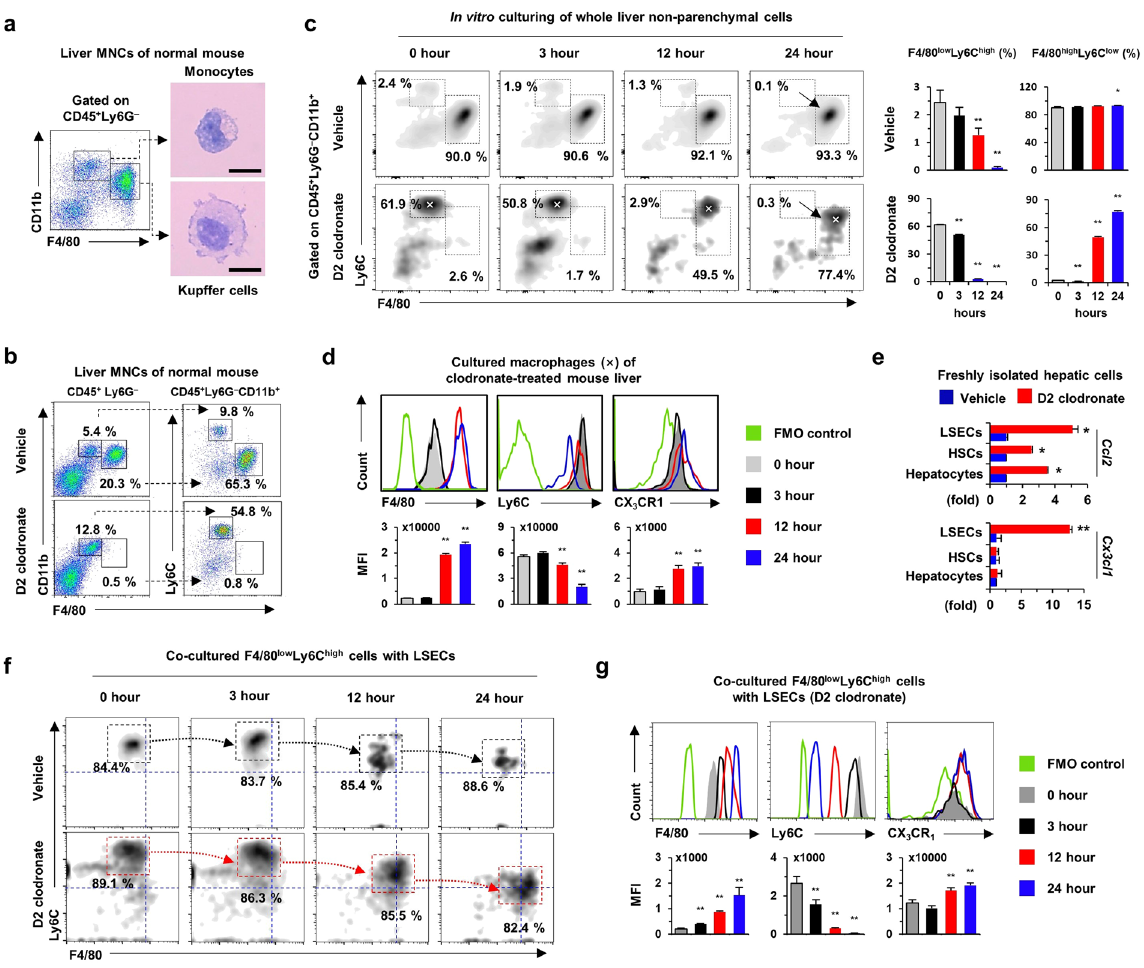
F4/80 high Ly6C low CX 3 CR1 high Kupffer-like macrophages. ( a ) Isolated mononuclear cells (MNCs) were subjected to flow cytometry. Monocytes and Kupffer cells were subjected to Giemsa staining. Bar = 10 μ m. ( b ) Kupffer cells were depleted by clodronate liposome treatment for 2 days (D2 clodronate). ( c , d ) Untreated whole liver non-parenchymal cells or cells treated with D2 clodronate were cultured in vitro for 24 h and analyzed by flow cytometry. ( e ) Gene expression was analyzed in isolated LSECs, hepatic stellate cells, and hepatocytes. Data are expressed as the mean ± SEM. * p < 0.05, ** p < 0.01 compared to corresponding control. ( f , g ) Isolated F4/80 low Ly6C high monocytes were co-cultured with LSECs of vehicle or D2 clodronate-treated mice for 24 h and they were subjected to flow cytometry. Data are expressed as the mean ± SEM. * p < 0.05, ** p < 0.01 compared to 0 h. The results represent three independent